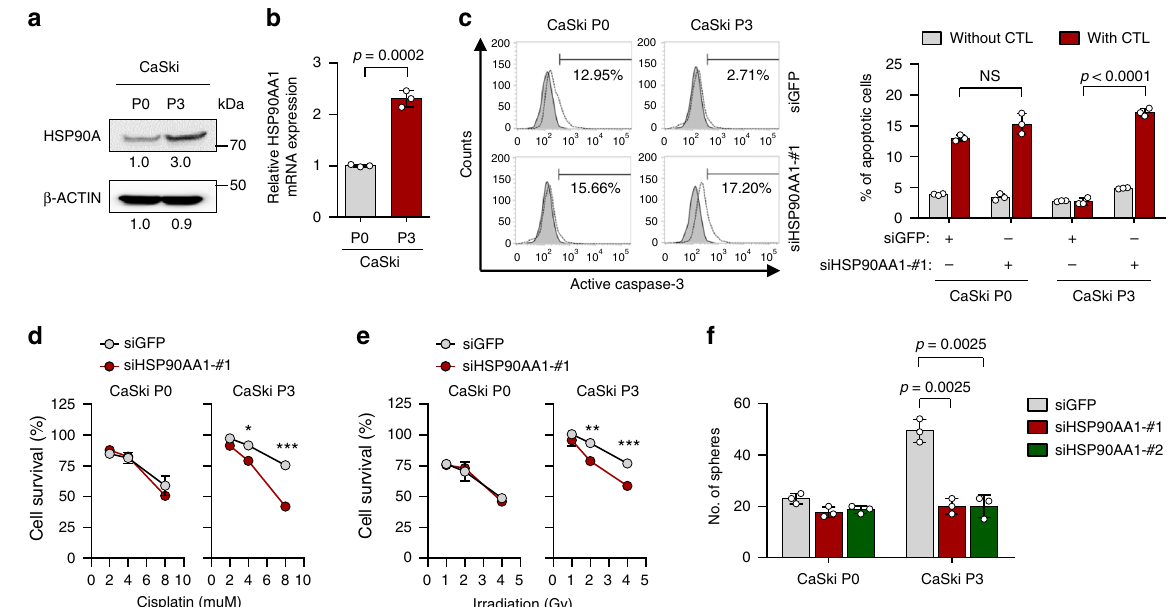
Fig. 1 HSP90A is required for multi-aggressive properties of immune-edited tumor cells. a HSP90A protein level in CaSki P0 and P3 cells was determined by Western blot. β -ACTIN was included as an internal loading control. Numbers below blot images indicate the expression as measured by fold change. b HSP90AA1 mRNA level in CaSki P0 and P3 cells was determined by qRT-PCR. c – e CaSki P0 and P3 cells were transfected with siGFP or siHSP90AA1-#1. c The frequency of apoptotic (active caspase-3 + ) cells in the MART-1 peptide pulsed cells after incubation with or without MART-1- speci fi c CTLs at a 1:1 ratio for 4 h was estimated by fl ow cytometry analysis. d and e Cells were treated with indicated concentrations of cisplatin d and irradiation e . The percentage of viable cells was determined by trypan blue exclusion assay at 24 h after either cisplatin treatment or irradiation. * p < 0.01, ** p < 0.001, and *** p < 0.0001. f CaSki P0 and P3 cells were transfected with siGFP, siHSP90AA1-#1, or siHSP90AA1-#2. Sphere-forming capacity of the cells in low-density suspension culture. All experiments were performed in triplicate. The p -values by two-tailed Student ’ s t test b or two-way ANOVA c – f are indicated. NS, not signi fi cant. Data represent the mean ± SD. Source data are provided as a Source Data fi le.